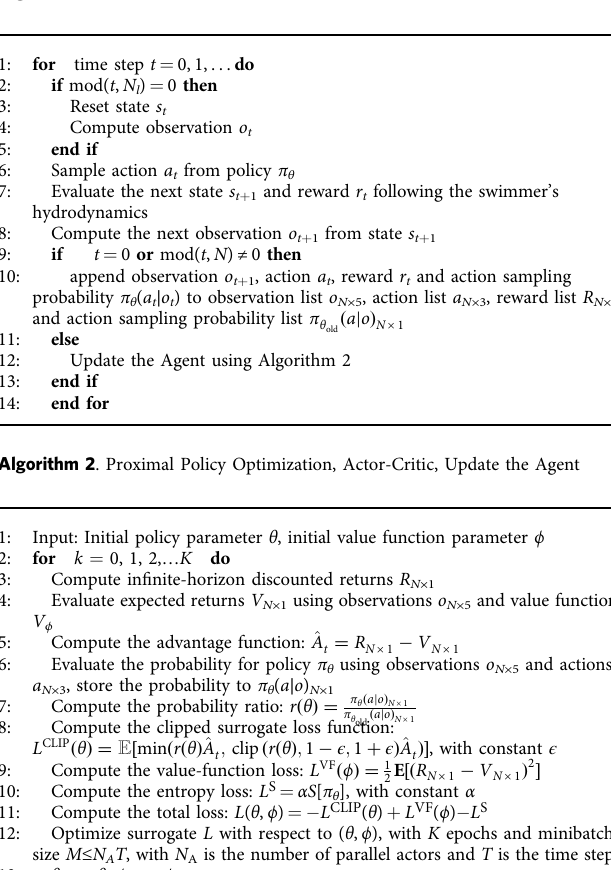
Algorithm 1 . Environment